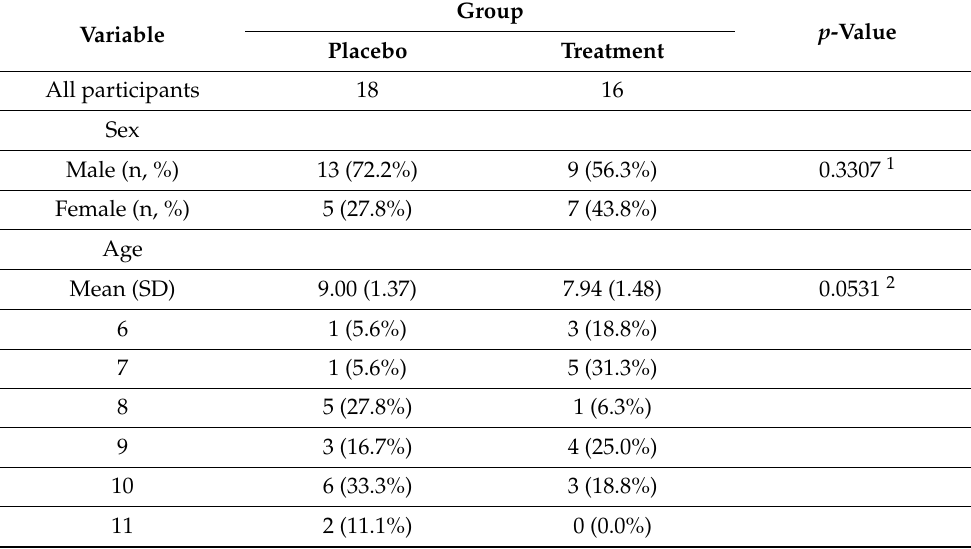
Table 3. Study participants’ baseline